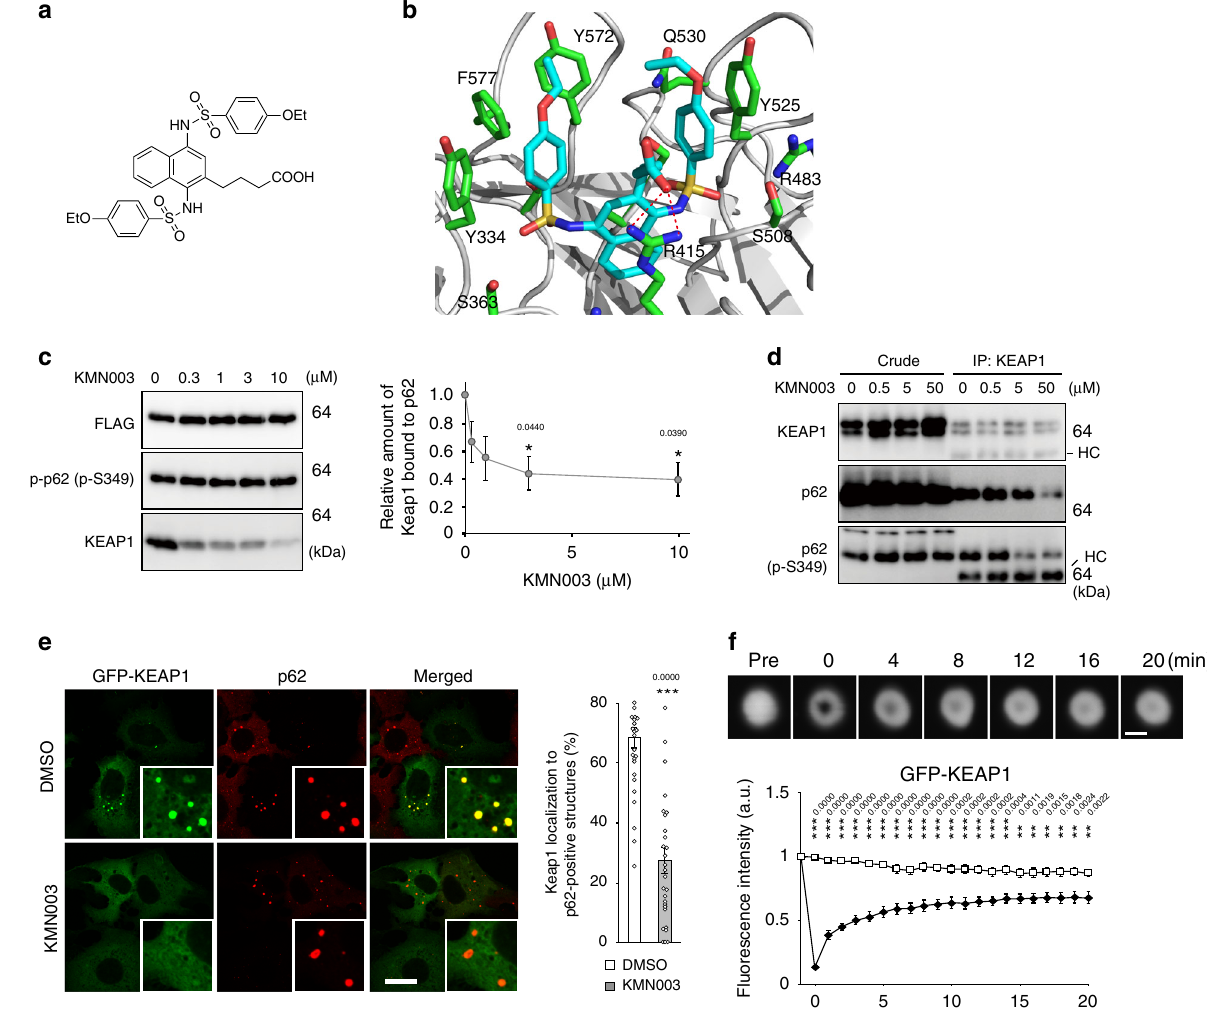
Fig. 6 Reversible translocation of Keap1 on the p62-gels. a Structural formulas of KMN003. ( b ) Modelling of Keap1 (white) – KMN003 (cyan). Overall structure of Keap1-DC, shown as a ribbon model. KMN003 (cyan) and some of the potential interacting residues of Keap1-DC are shown in stick representation (green). Potential hydrogen-bonds are depicted as dotted red lines. c In vitro pull-down assay. Recombinant Keap1-DC was allowed to form a complex with Strep - FLAG -tag p62, and then KMN003 was mixed with the complex at indicated concentration. Keap1-DC binding to Strep - FLAG -tag p62 was estimated by immunoblot analysis with Keap1 antibody. Data are representative of three independent experiments. Right graph indicates the quantitative densitometric analysis of Keap1 bound to p62 ( n = 3). Data are means ± s.e. * p < 0.05 as determined by two-sided Welch ’ s t -test. Source data are provided as a Source Data fi le. d Immunoprecipitation assay. Huh-1 cells were cultured in regular medium in the presence or absence of KMN003 at indicated concentration for 12 h. Cell lysates were immunoprecipitated with Keap1 antibody, and the immunoprecipitants were subjected to immunoblot analysis with the indicated antibodies. Data shown are representative of three separate experiments. HC indicates heavy chain. Source data are provided